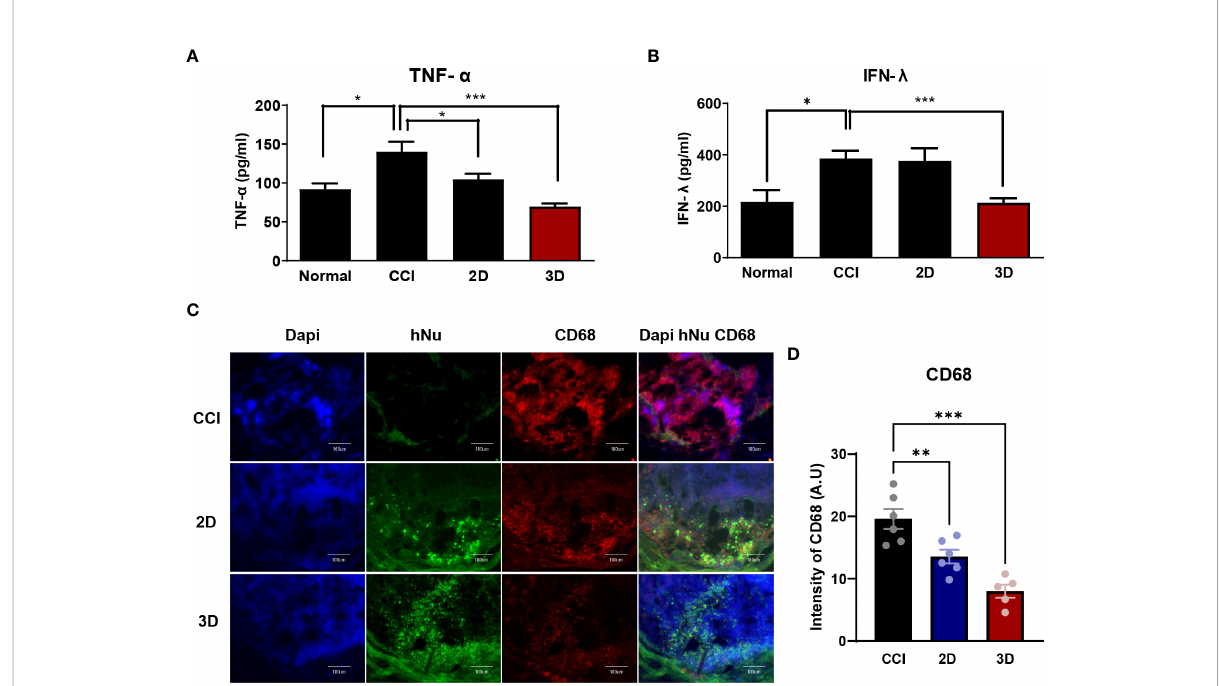
FIGURE 5 The expression of in fl ammatory factors in CCI, MSC 2D and 3D graft sites. Pro-in fl ammatory cytokine tumor necrosis factor- a (TNF- a ) (A) and interferon- g (IFN-r) (B) level in normal, CCI and cell transplantation groups. Cytokine concentrations are indicated as pg/ml (n = 6 per group). (C) Immuno fl uorescence staining of CD68 positive cells (Red) and human nuclei positive cells (hNu; Green) double staining with DAPI (Blue) in the cell transplantation region. Scale bar: 100 m m. (D) Quanti fi cation of CD68 intensity in the CCI and cell transplantation groups. (n = 6 per group). The area and fl uorescent intensities of all CD68 positive cells in each cell grafted regions measured by Image J. Intensity is indicated as arbitrary unit (A.U.). Scale bar: 100 m m. Data are presented as mean ± SEM. Statistical differences for the intensities of CD68 expression were analyzed using one-way ANOVA, followed by Tukey ’ s post hoc test, *p < 0.05, ** p < 0.01, *** p <